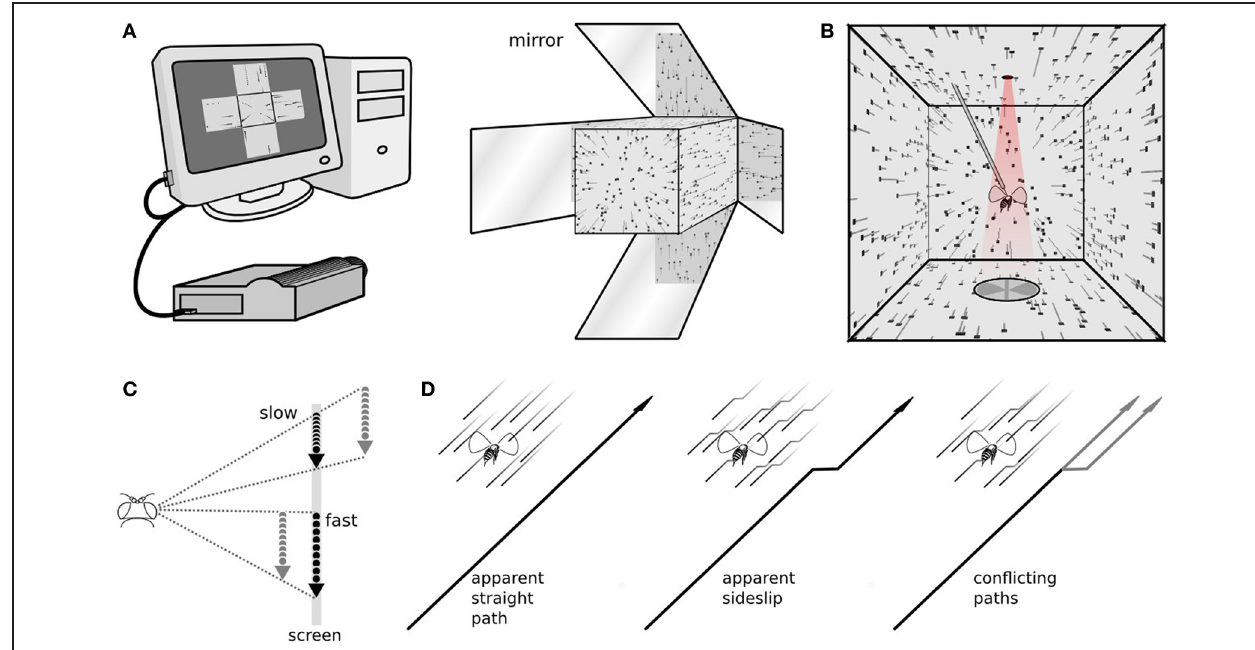
gray lines illustrate the dot velocities, but weren’t part of the stimulus. Above the fly is an infrared light, and below are a pair of photodiodes, that together measure the amplitude of each wingstroke. (C) Dots move at different speeds across the screen. A moving viewer can reconcile these as stationary points at different distances. (D) Optic flow simulating forward motion, forward motion with an abrupt sideslip, and an ambiguous situation, where some points indicate a straight path and others a sideways